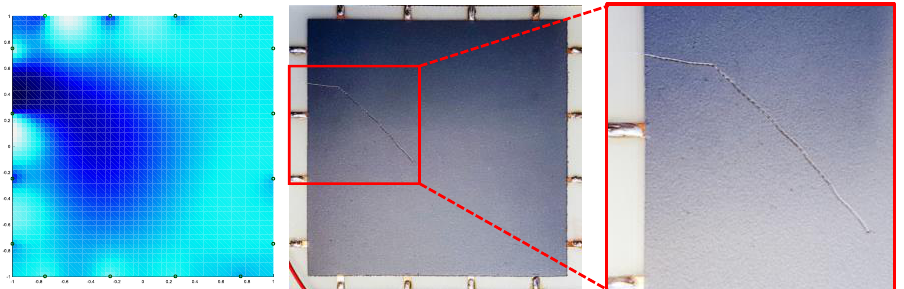
Figure 17. ERT damage identification test.